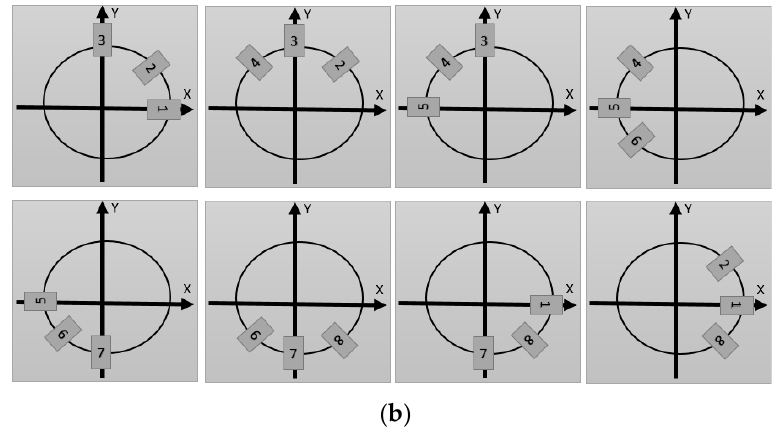
Figure 2. ( a ) Special strain gauge rosette with eight grids used for strain measurement, ( b ) eight different combinations of strain gauge grids used for determination of residual stresses.